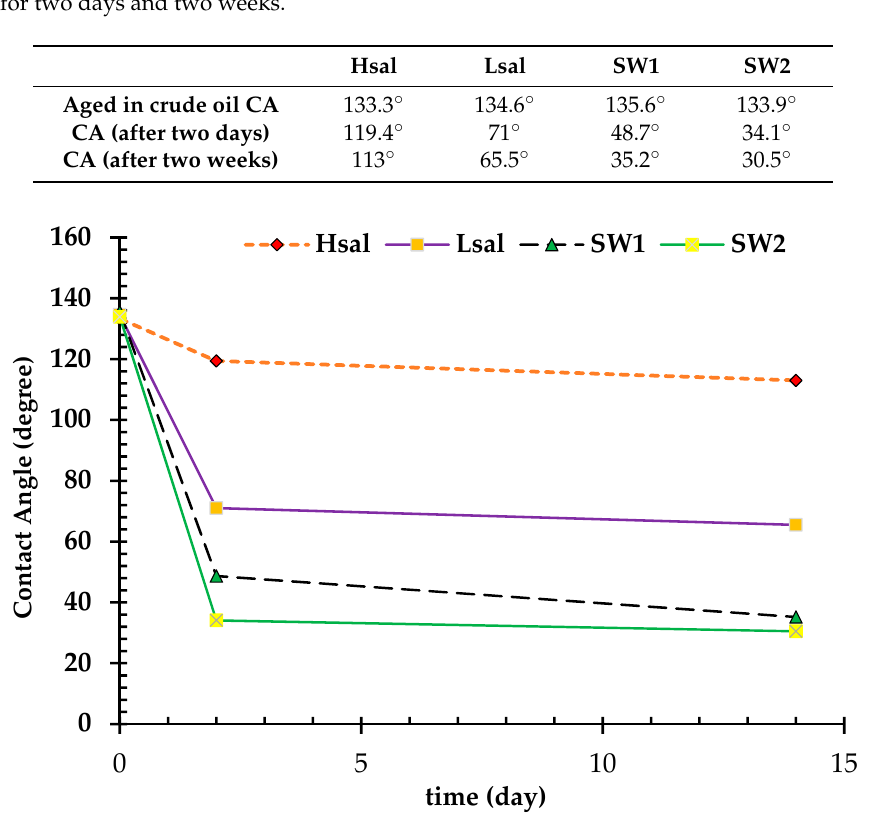
Figure 12. Change in CA after treatment of Case 5 (strongly oil wet) calcite surface with different brines for two days and two weeks.